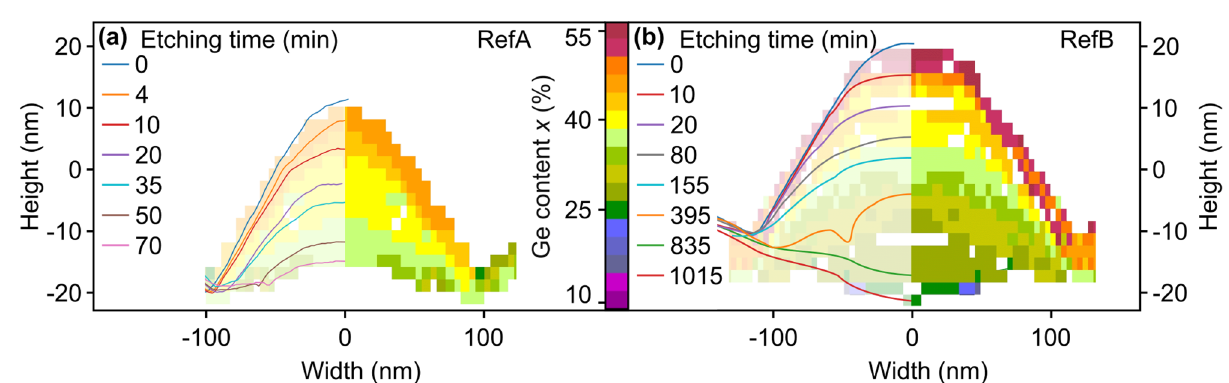
Figure 2. ( a ) HAADF image of ordered QD stacks in pits. ( b ) Bright-field image of a QD-stack in a pit. ( c ) HAADF image of randomly nucleated QD-stacks from an un-patterned area of Sample D. ( d ) Zoom-in of a QD-stack of image ( c ).